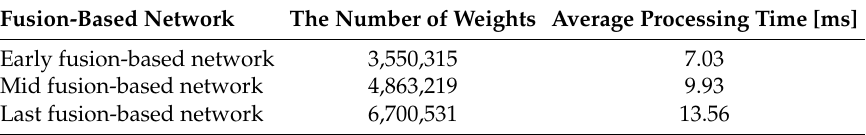
Table 4. Complexity performance results of the proposed fusion-based color image generation in terms of the number of weights and average inference processing